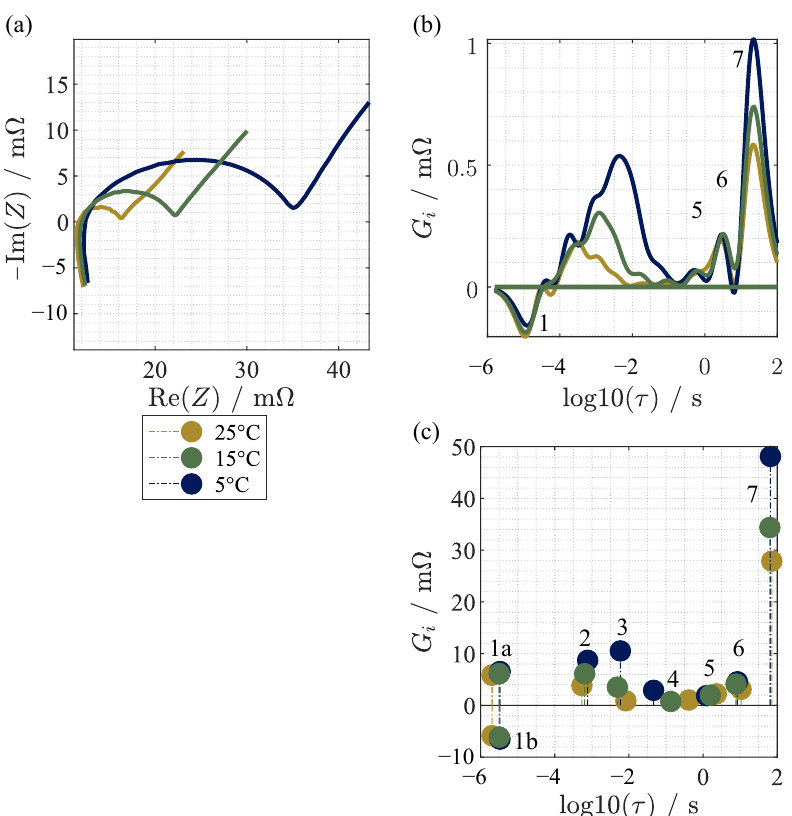
Figure A1. Nyquist plot ( a ), distribution of gains obtained by gDRT ( b ), distribution of gains obtained by LWF ( c ) of the measurement data at different